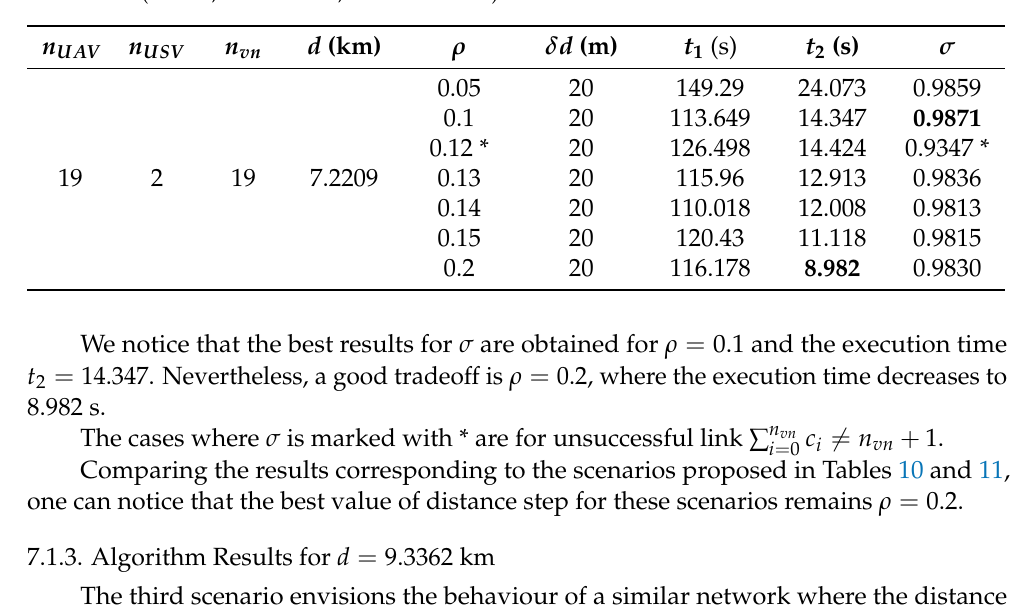
Table 11. Algorithm results: execution time (before and after the improvement) and performance indicator σ ( nt = 3, LB = 92 dB, d = 7.2209